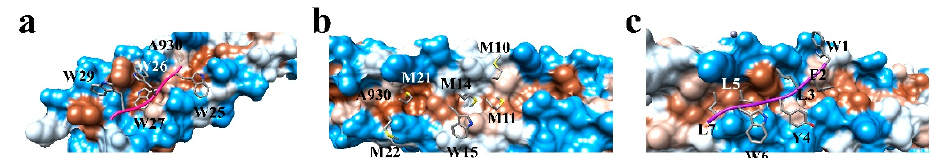
Figure 8. Hydrophobic interactions occurring between SARS-CoV-2 HR1 WT domain and designed peptide inhibitors. Side chains of the designed peptide inhibitors are shown as ribbon structures and/or atoms and bonds. The HR1 domain of SARS-CoV-2 is shown as a hydrophobic surface where blue color indicates hydrophilic regions and brown color indicates hydrophobic regions. The white color indicates regions neither strongly hydrophilic nor hydrophobic. ( a ) HR1 of SARS-CoV-2 WT domain (surface) interactions with hydrophobic residues on the C terminal region of peptide inhibitor (pink) which flanks the core alpha helix. ( b ) HR1 of SARS-CoV-2 WT domain (surface) interactions with hydrophobic residues in the helix region of peptide inhibitor (atoms and bonds). ( c ) HR1 of SARS-CoV-2 WT domain (surface) interactions with hydrophobic residues on the N terminal region of designed peptide inhibitors (purple) which flanks the core alpha helix.